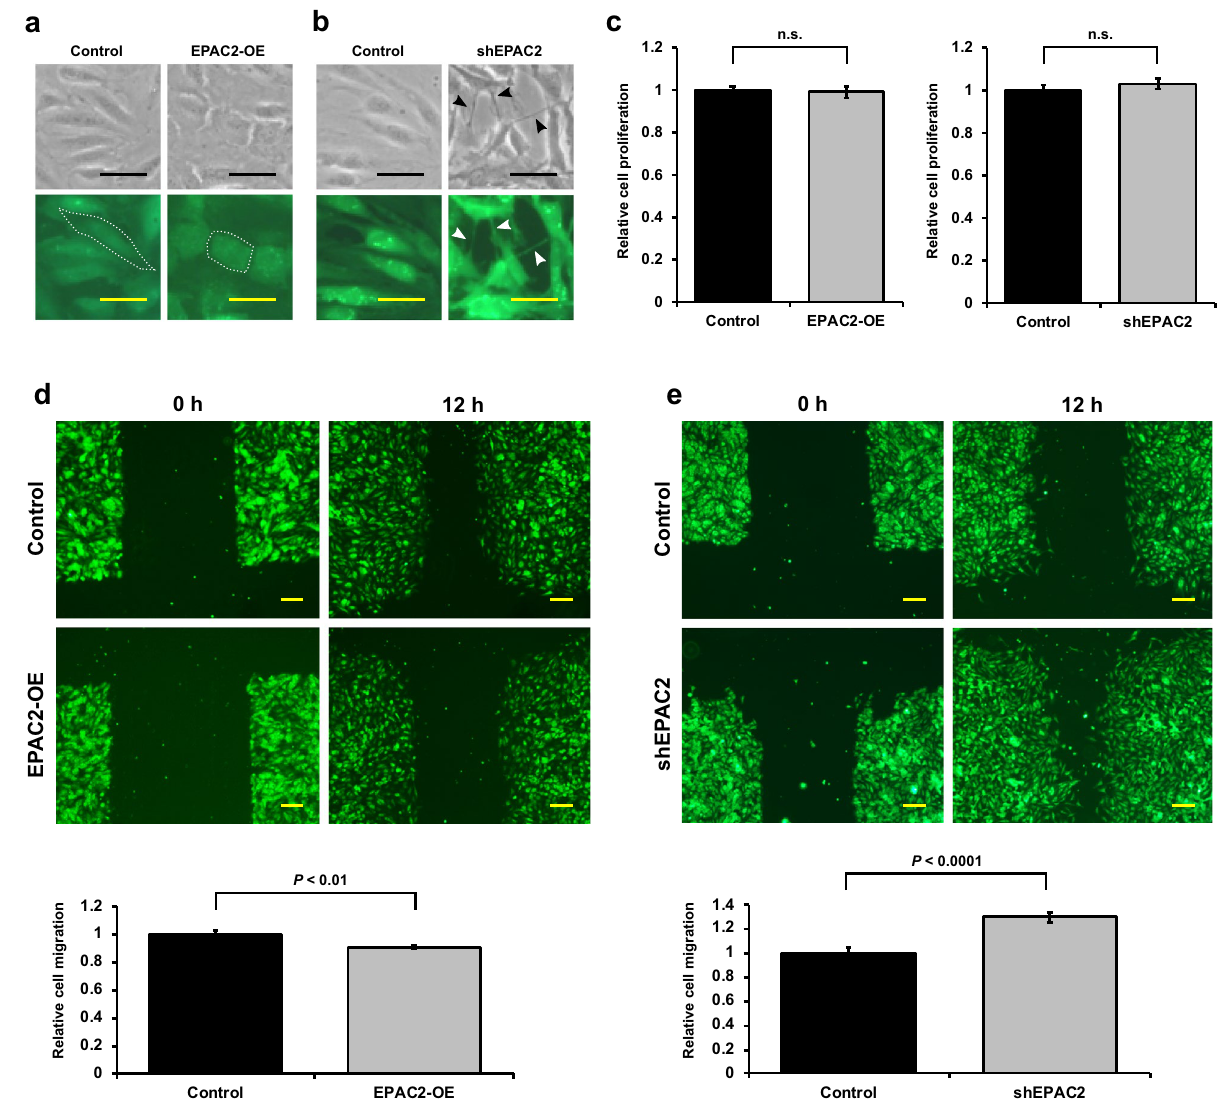
Figure 5. EPAC2 regulates cell migration of endothelial cells. ( a,b ) Cell morphology in EPAC2 overexpressing ( a ) and knockdown ( b ) TIME cells. Images were taken using phase contrast (upper panel) and fluorescence microscopy (lower panel). Representative cell shapes are surrounded by dotted lines. Filopodia-like protrusions are indicated with arrowheads. Scale bars: 50 μm. ( c ) Cell proliferation was evaluated as described in the Methods section. Data were expressed as mean ± S.E.M. (n = 6). ( d,e ) Cell migration of TIME cells was blocked by EPAC2 overexpression ( d ) and accelerated by EPAC2 knockdown ( e ). Cells were scratched and followed by culture for 12 h. Data were expressed as mean ± S.E.M. (d; n = 24 and e; n = 18). Scale bars: 200